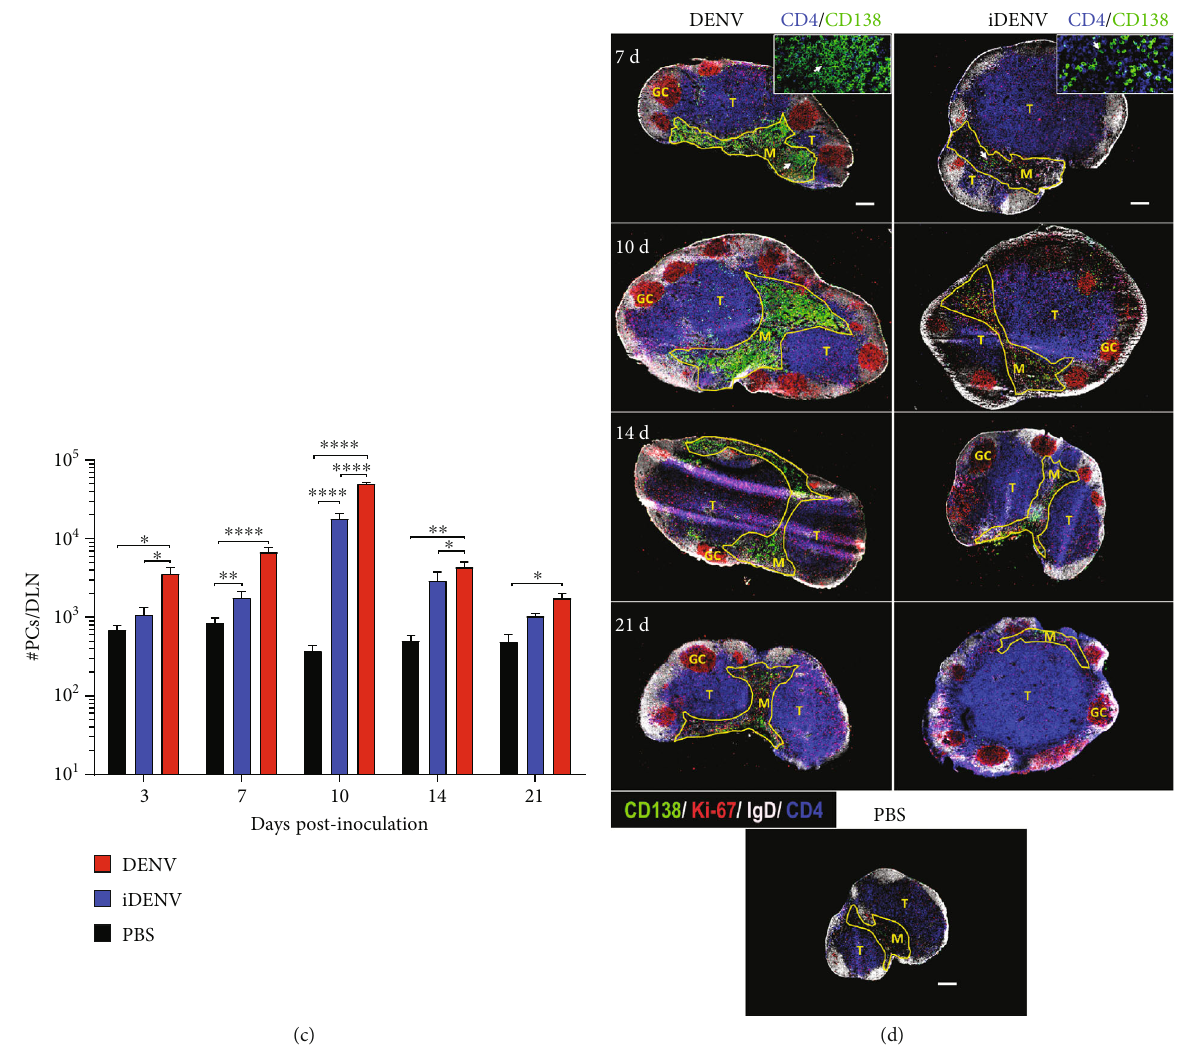
Figure 1: Dynamic of PCs in the draining lymph node (DLN) of immune-competent mice induced by cutaneous DENV inoculation. (a) Mice were inoculated intradermally (i.d.). with 6 × 10 4 PFU of DENV, UV-inactivated DENV (iDENV), or endotoxin-free PBS at day 0, boosted at day 7, and samples were collected at the indicated days. PCs in the DLN were analyzed by fl ow cytometry, gating on single/live cells/CD138 + Ly6C + (Figure S1). (b) Representative contour plots during the kinetic p.i. shows the proportion of PCs with the di ff erent conditions. Numbers indicate the proportion of PCs among total single/live cells. (c) Absolute numbers of PCs at days 3, 7, 10, 14, and 21 p.i. (d) DLN cryosections labelled for CD138 (green), CD4 (blue) to identify the T zone (T), IgD for follicular B cells (white), and the proliferation marker Ki-67 (red). GCs are Ki-67 + cells inside IgD-negative areas. The medulla (M) is depicted in yellow solid line. Left and right panels show DLNs from DENV- and iDENV-inoculated mice, respectively, whereas the bottom panel shows a representative DLN from noninfected PBS-inoculated mice. A higher magni fi cation of medulla CD138 + and CD4 + cells is shown for day 7 (white arrow) to illustrate speci fi c staining of CD138 + PCs. Scale bars represent 200 μ m. Flow cytometry data shown represent the mean ± SEM from at least four independent experiments with two mice per group per time point and histology results from two experiments with four mice per group per time point. Two-way ANOVA with Bonferroni posttest were used for the statistical analysis. ∗ P < 0 : 05 , ∗∗ P < 0 : 01 , ∗∗∗ P < 0 : 001 , and ∗∗∗∗ P < 0 : 0001